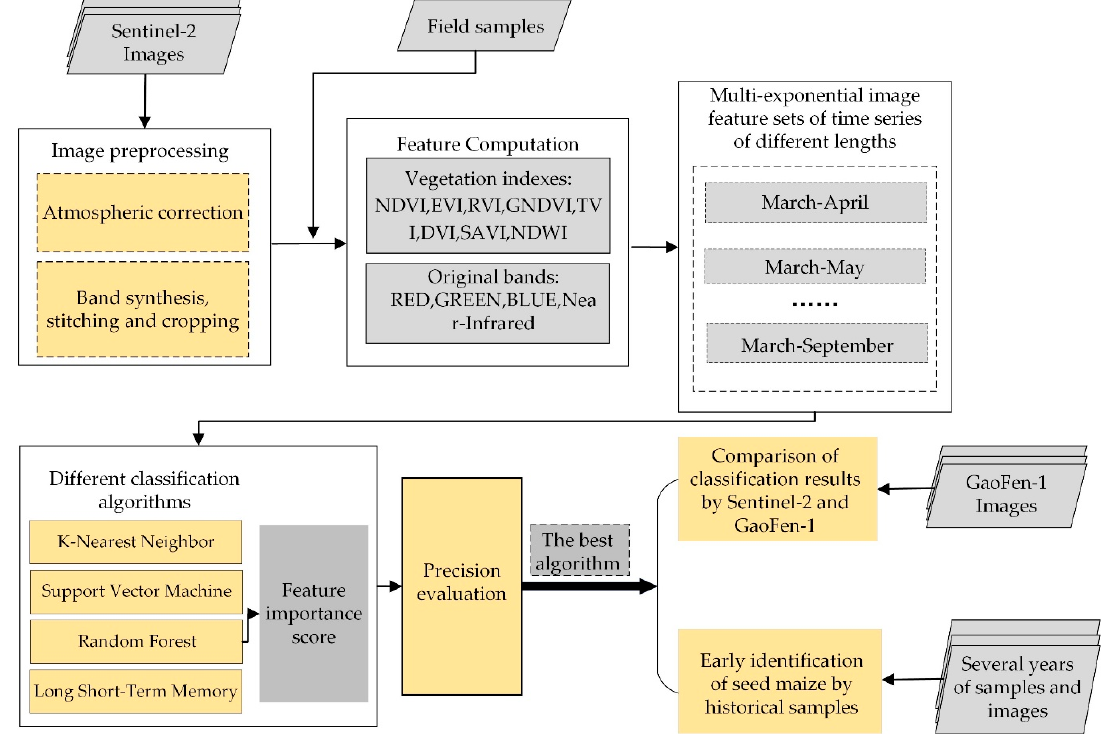
Figure 3. Flowchart of the steps in the early identification of seed maize.